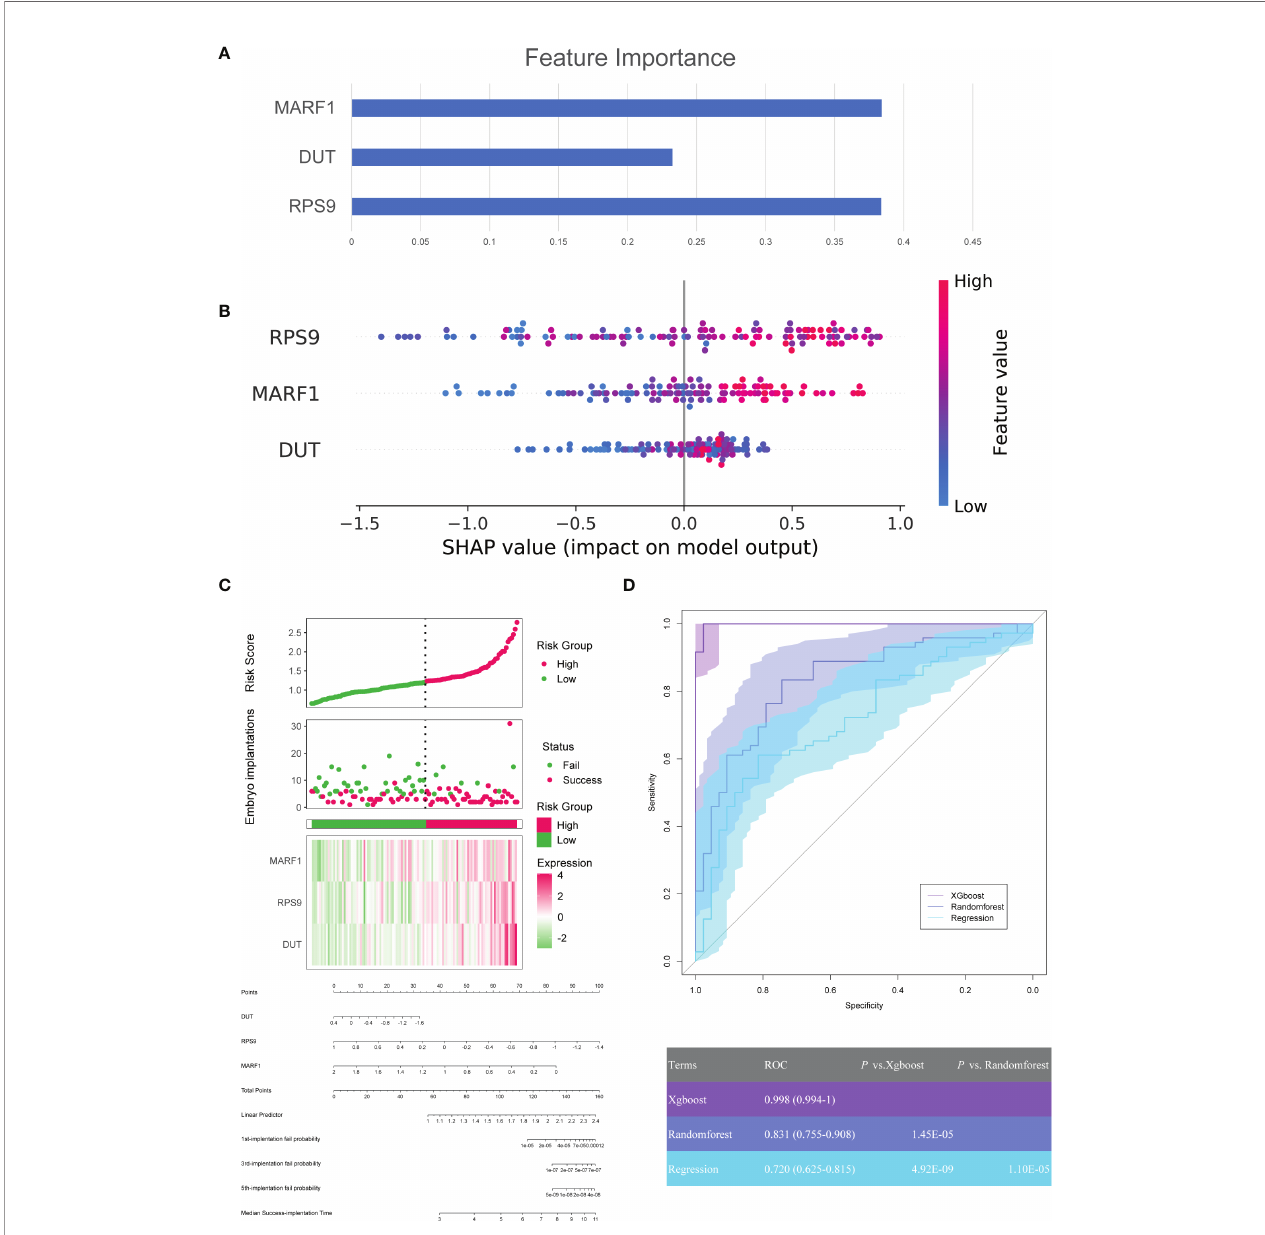
FIGURE 5 | Construction of machine learning model for clinical pregnancy prediction. (A) SHAP values of each feature for random forests in modules. Each point represents a sample, and the fi gure shows the impact of features on the model ’ s outcome. (B) The weight matrix of hub genes in the xgboost model. Each column represents the weight of each feature to the model outcome in one permutation. (C) The predictive values of DUT, RPS9, MARF1, and the risk model were established based on logistic regression and visualized by a nomogram. (D) ROCs for machine learning